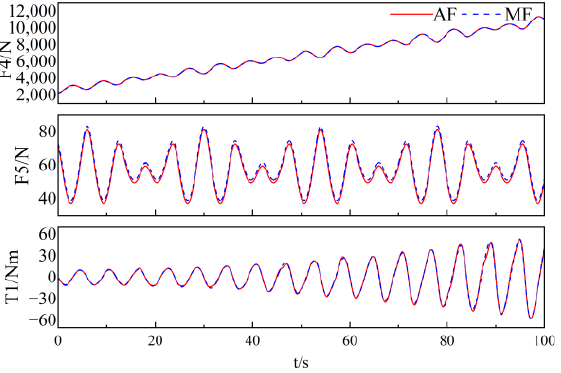
Figure 17. Tractive force or driving torque of each joint of the transfer gangway under the actual person transfer operation.